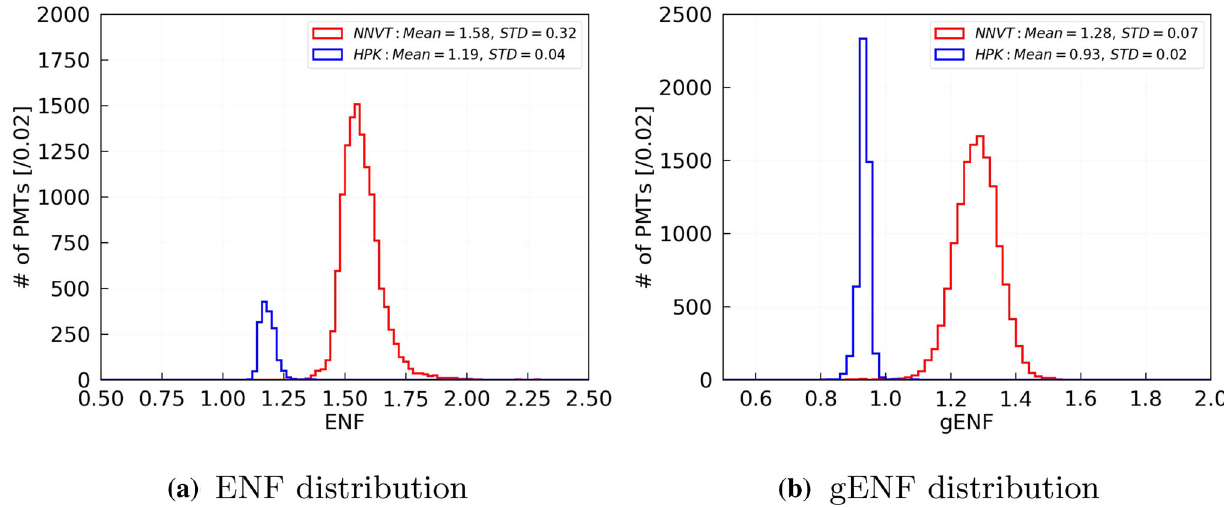
Fig. 16 Left: ENF distribution of all qualified bare PMTs. Right: gENF distribution of all qualified bare PMTs. Red: NNVT; blue: